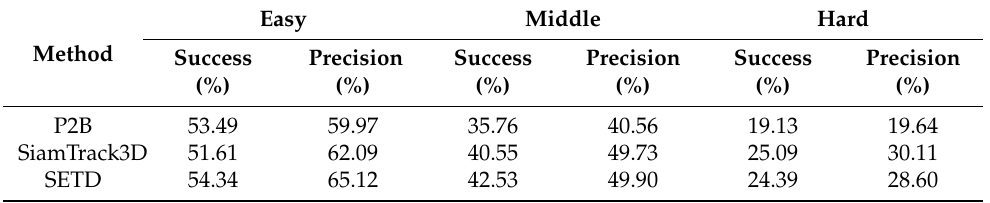
Table 3. Performance comparison with the state-of-the-art methods on PandaSet. The results on three sets of different difficulty levels are